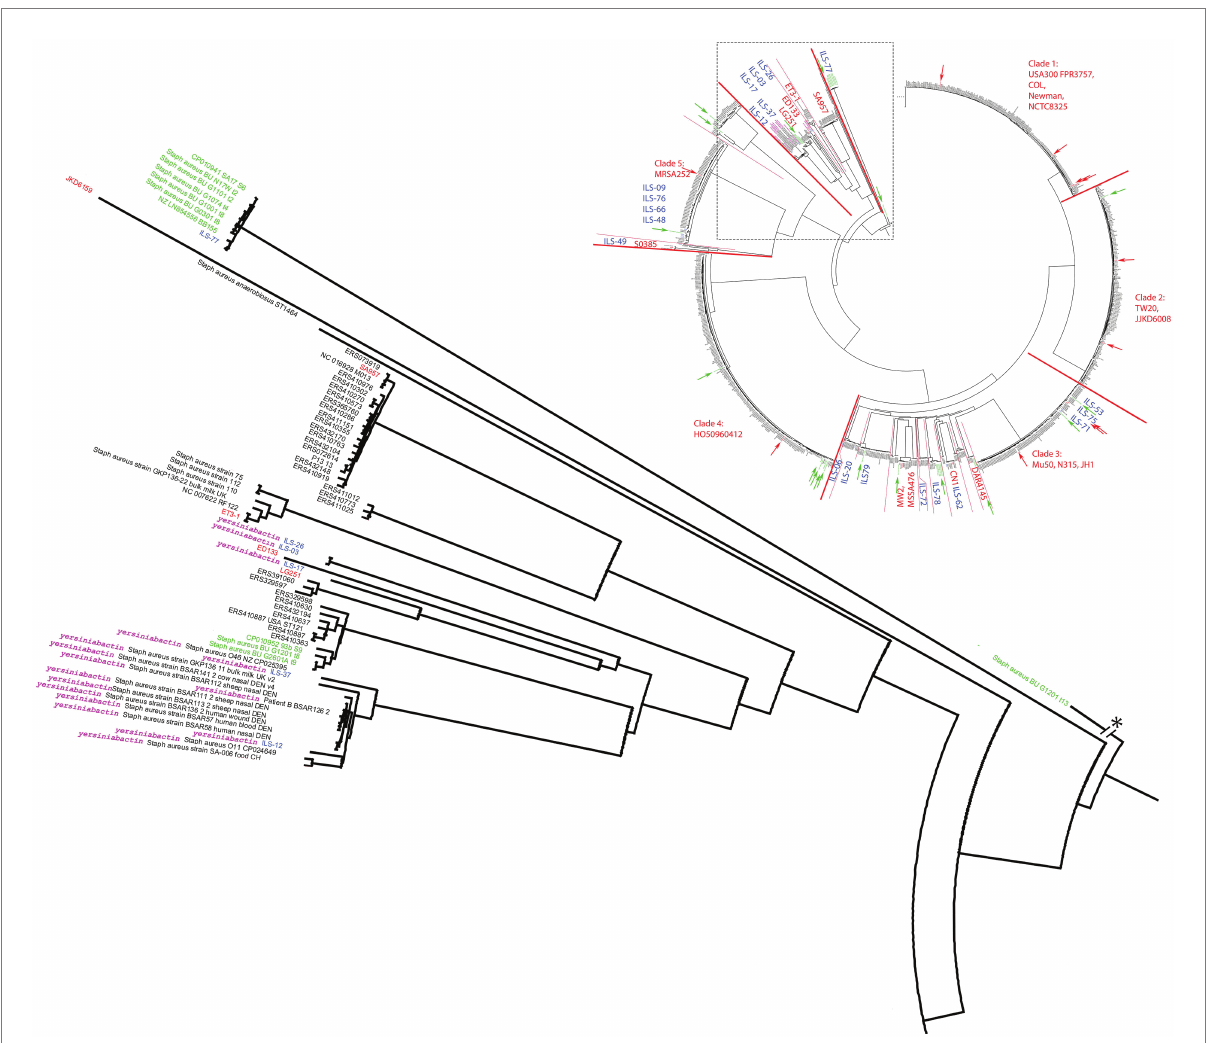
FIGURE 2 Detailed view of the S. aureus cgMLST tree clade comprised of strains carrying the putative yersiniabactin operon. The clade is extracted near the root of the cgMLST tree of 956 S. aureus strains ( Figure 1). All putative yersiniabactin carriers are highlighted in purple. Strains derived from this study are highlighted with blue ILS-tags. Strains of African origin are highlighted in green. Reference strains are highlighted in